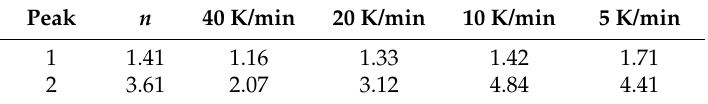
Figure 6. JMA plots for 1st ( a ) and 2nd ( b ) crystallization peaks of Al 82 La 10 Fe 4 Ni 4 amorphous alloys at different heating rates. at different heating rates. Table 3. The Avrami exponent in the first and the second crystallization Table 3. The Avrami exponent in the first and the second crystallization peaks.